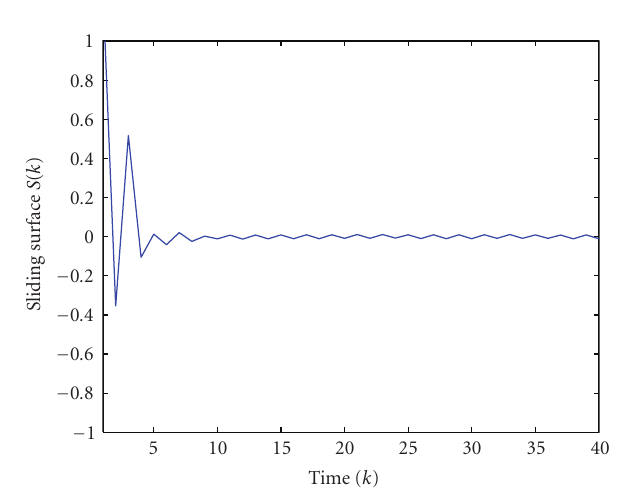
Figure 3: Sliding surface S ( k ).